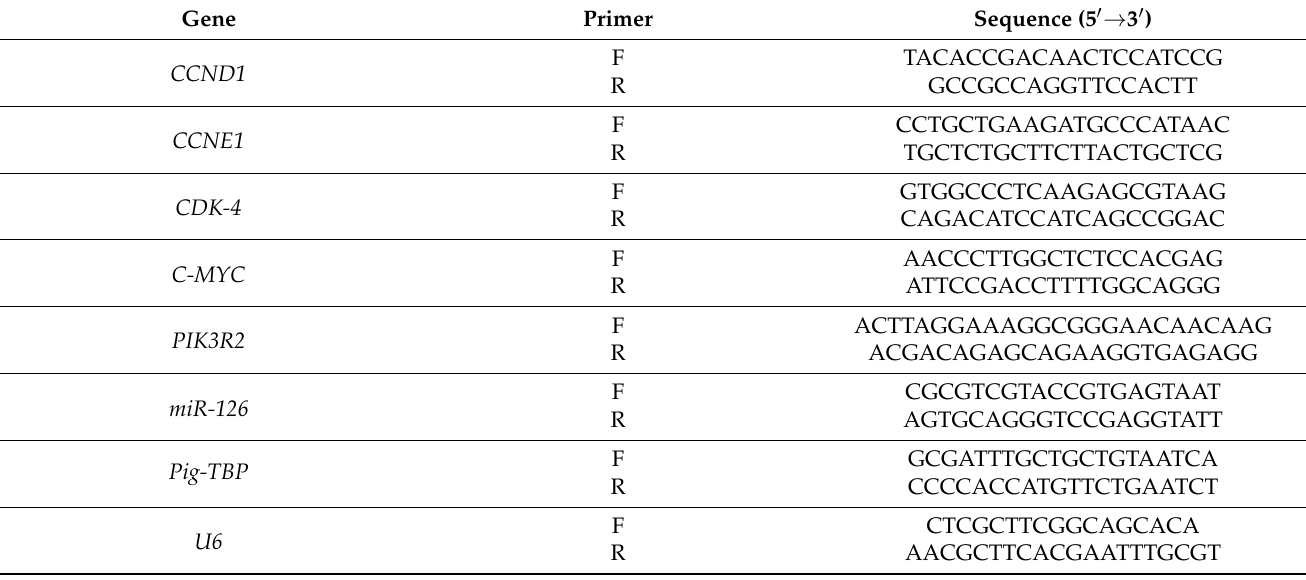
Table 1. The sequences of the primers used in this